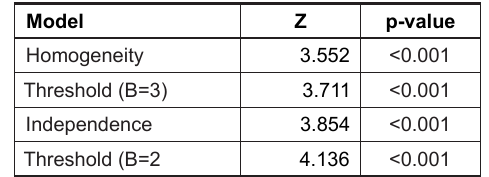
Table 19. Summary of collar and group data for the 2015 Bluenose-West post calving survey.